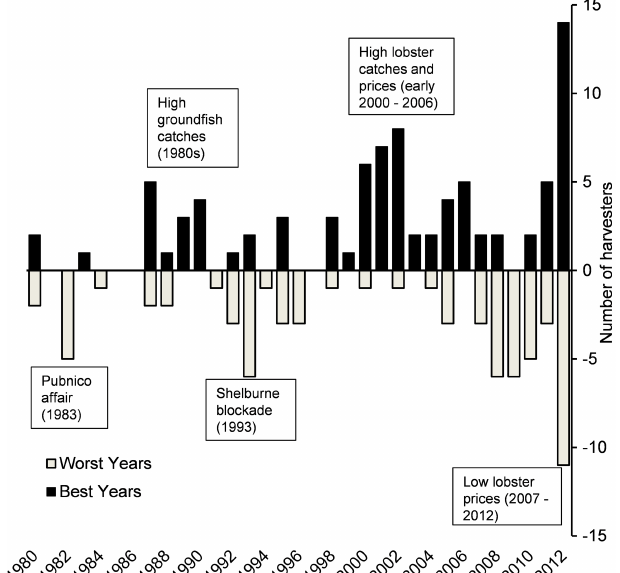
Fig. 4 . Frequency histogram of years that harvesters reported as best and worst, with reference to significant events in southwest Nova Scotia fisheries (text